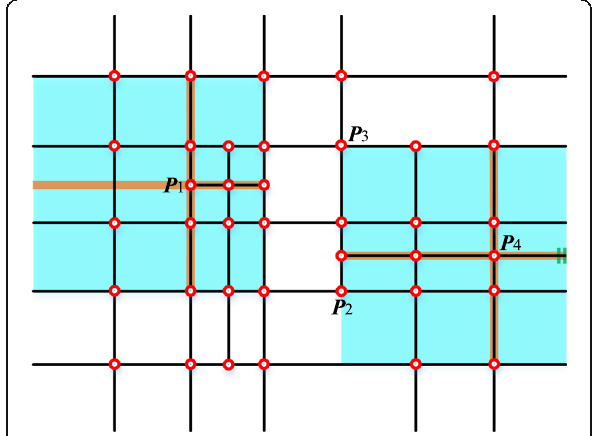
Fig. 2 An example of the local knot interval